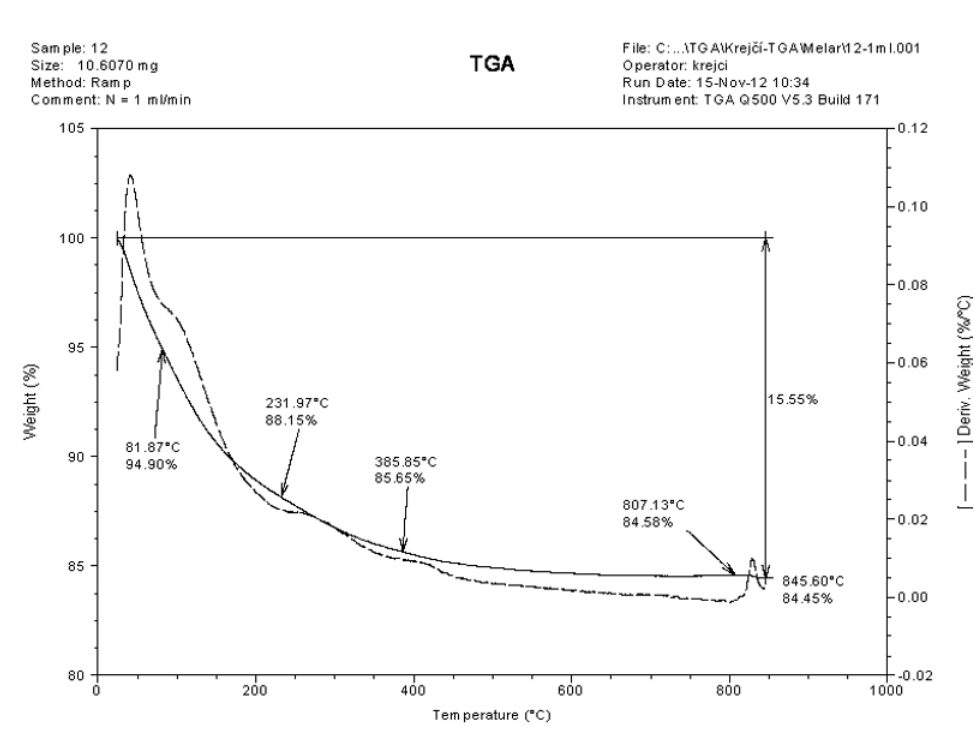
Figure 7. TG/DTG curve of an untreated